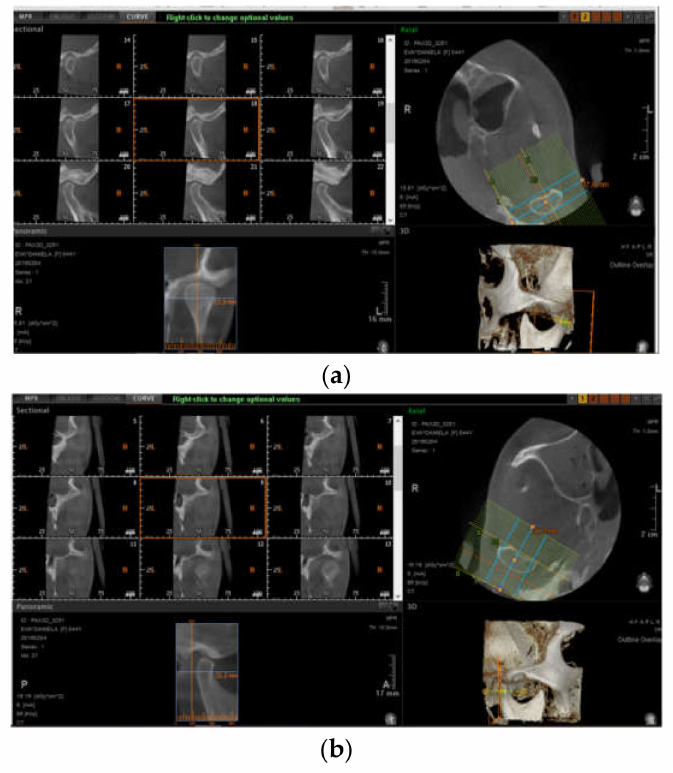
Figure 3. CBCT aspects of the ( a ) right and ( b ) left